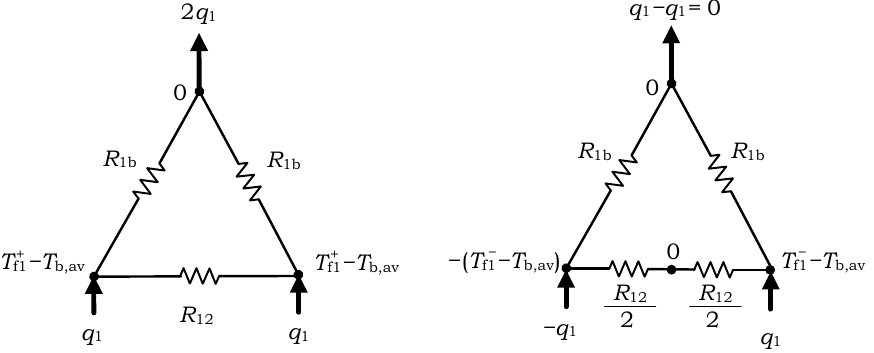
Figure 4. Thermal resistance networks for equal pipes in symmetric positions for even ( left ) and odd ( right ) cases.